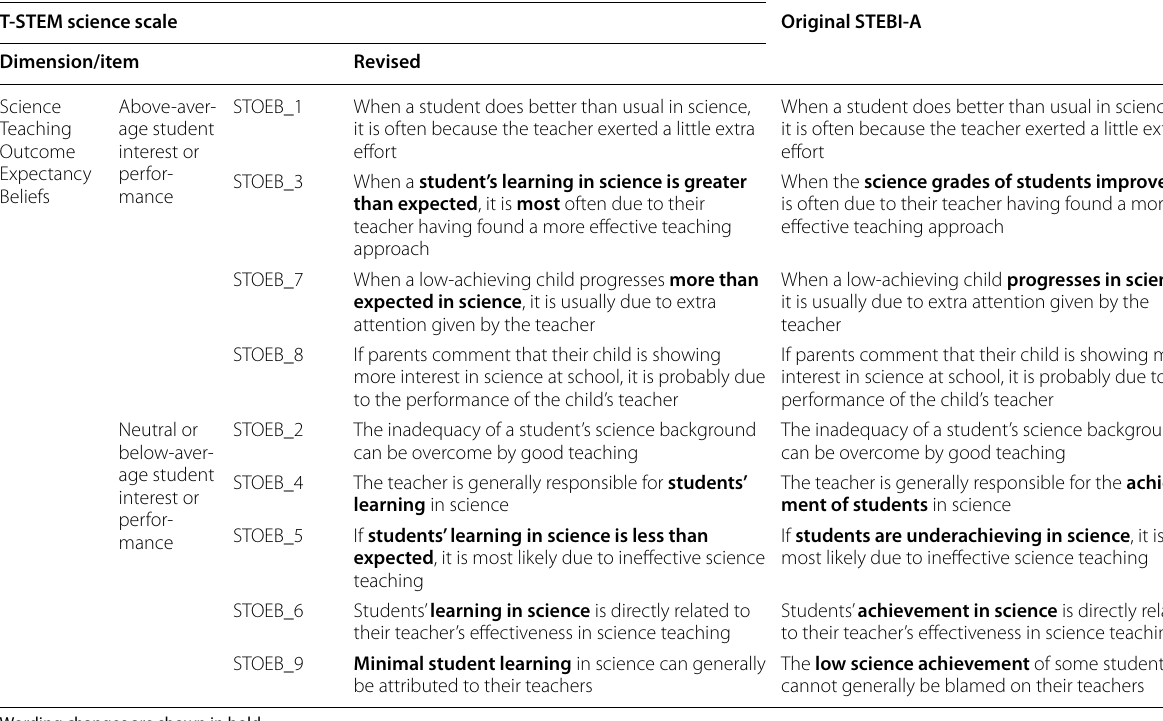
Wording changes are shown in bold